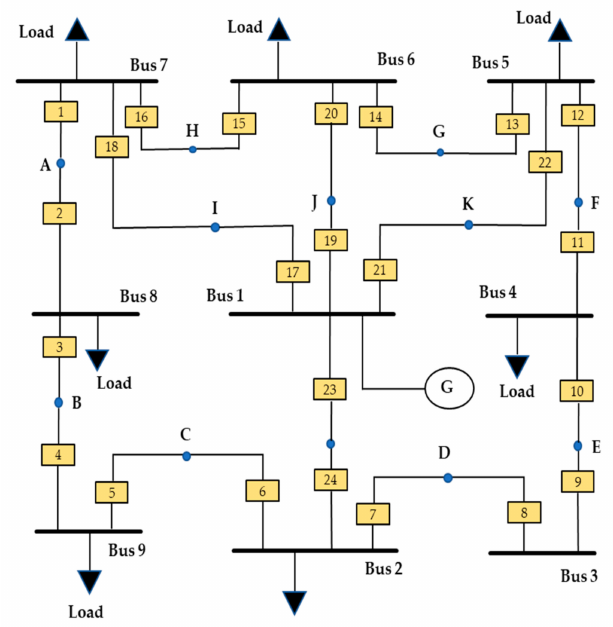
Figure 7. The IEEE nine-bus system.